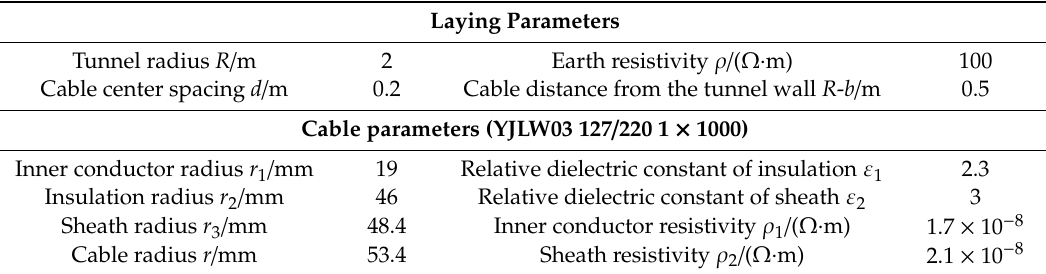
Figure 4. Relationship between the real parts of the characteristic admittances and the frequency. Table 1. Parameters of layout and cable. Laying